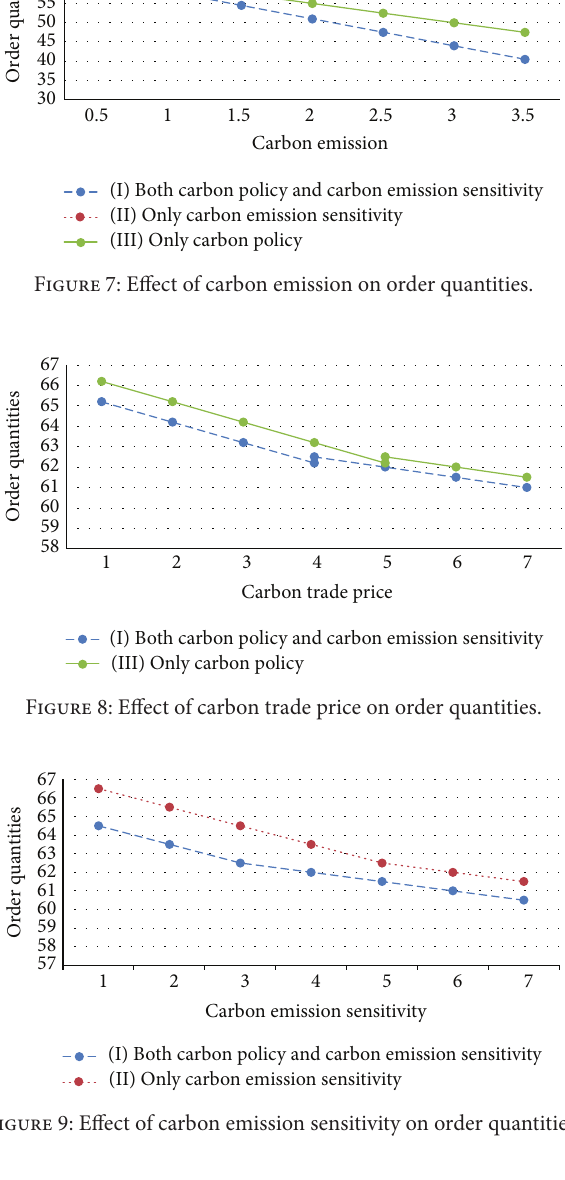
Figure 5: Effect of carbon emission sensitivity on retail prices.